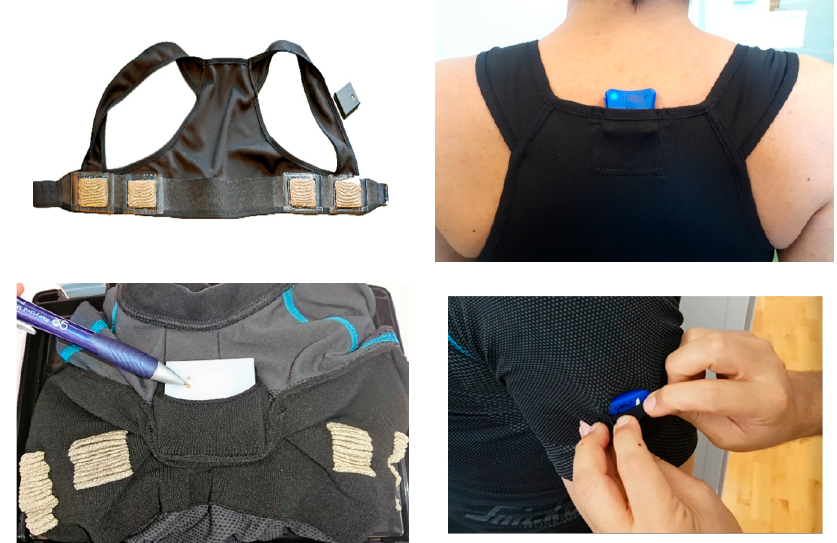
Figure 2. Vest ( top ) and t-shirt ( bottom ), including textrodes and ECGZ2 and Figure 2. Vest (top) and t-shirt (bottom), including textrodes and ECGZ2 and IMUs.